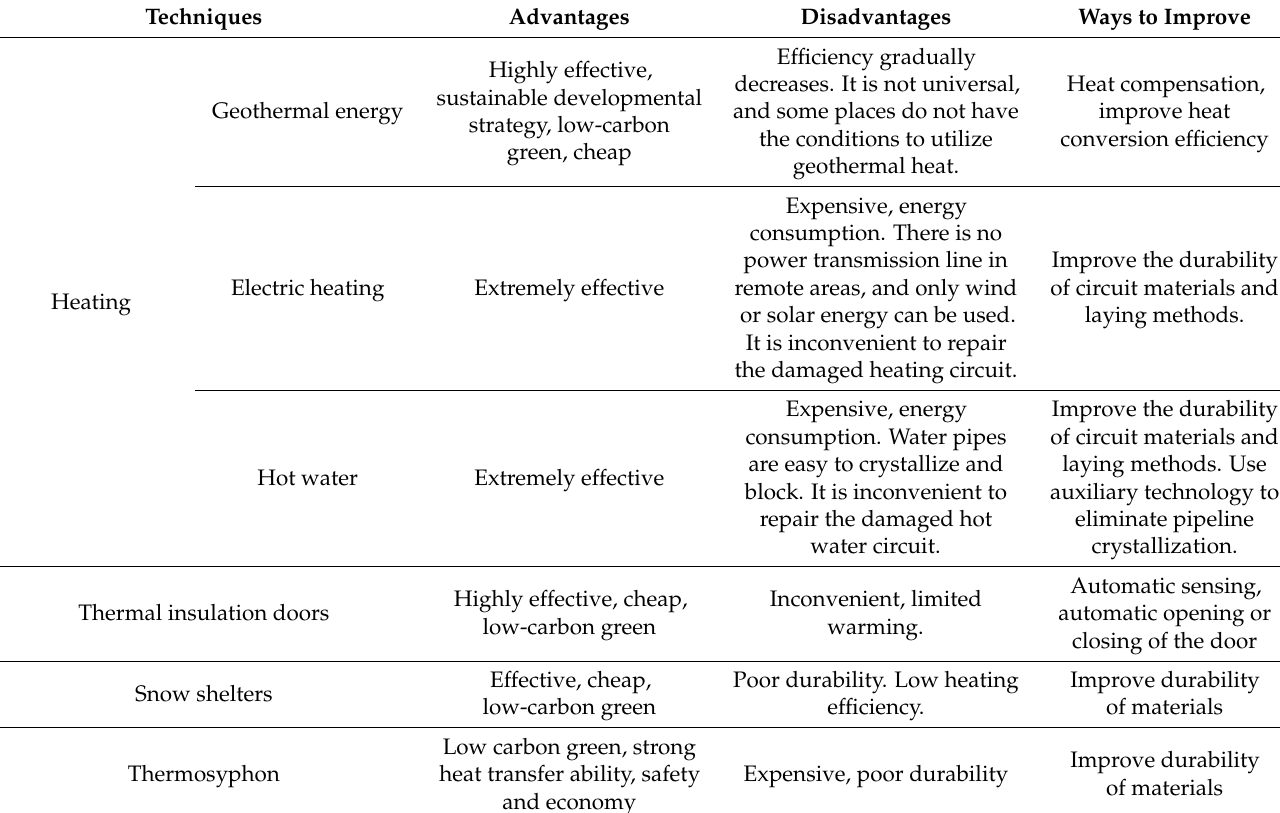
Figure 6. Snow shelter at the entrance of a tunnel (photographed by Y.F. Zhou). Table 9. Comparison of advantages and disadvantages of different